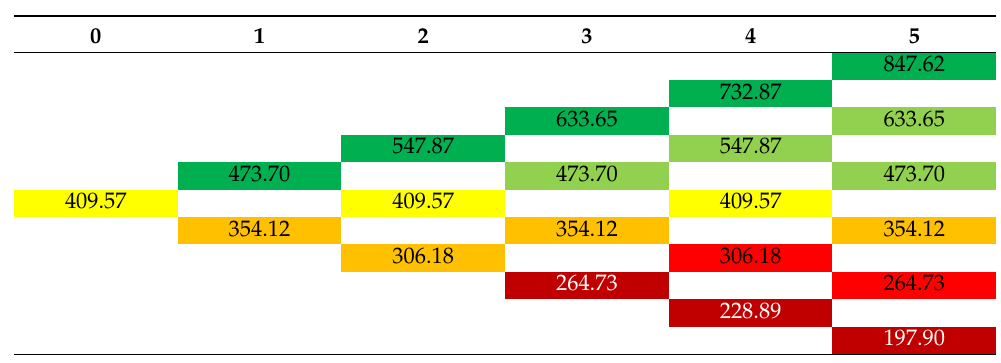
Table 4. Binominal option pricing model: a lattice of the underlying values of Amazon after the acquisition of Souq.com (in USD billion).